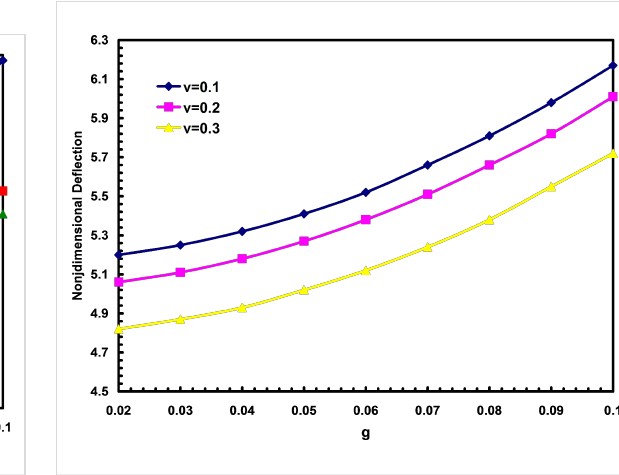
Figure 4: The effects of nonlocal parameter and aspect ratio on the deflection ratios.